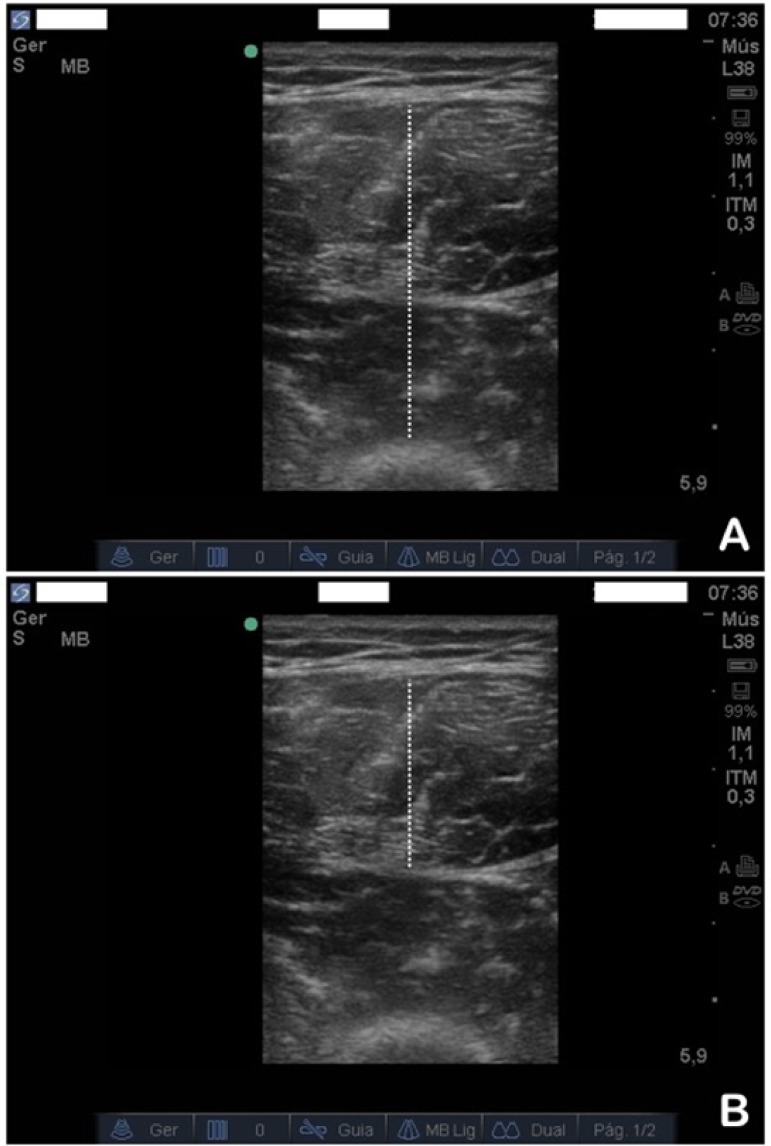
Example of image processing to measure muscle thickness. The dotted line represents total quadriceps thickness on panel (A) and rectus femoris thickness on panel (B).